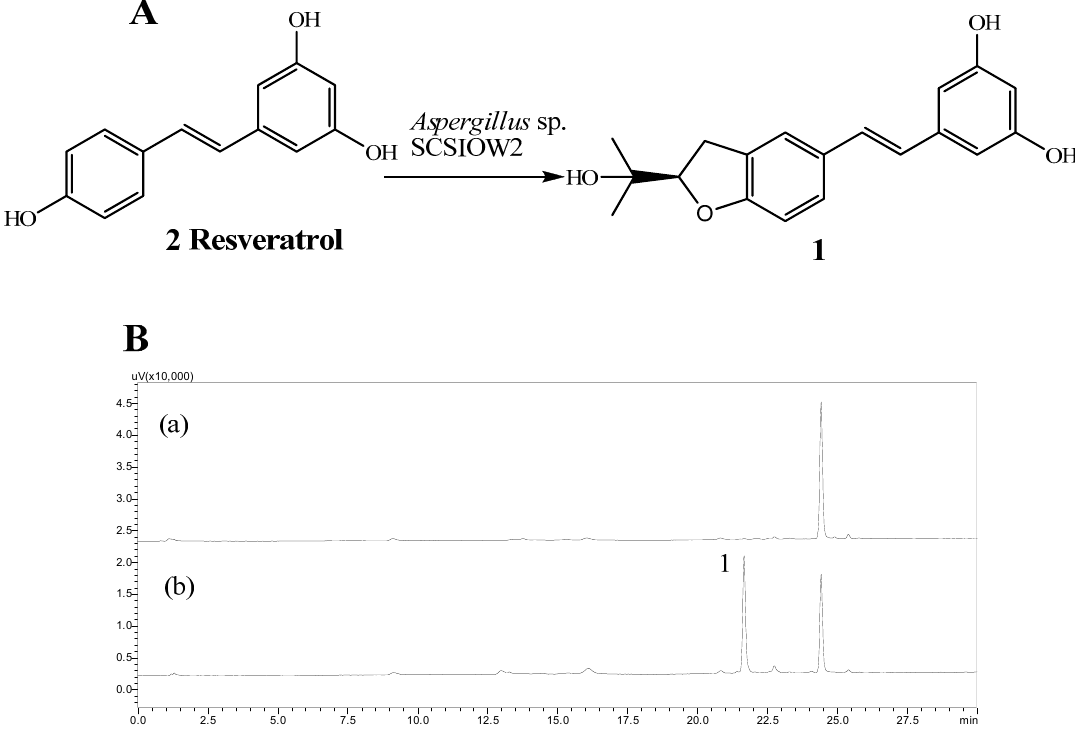
Figure 1. The conversion of trans -resveratrol into 1 is catalyzed by Aspergillus sp. SCSIOW2. ( A ): Structures of trans -resveratrol ( 2 ) and arahypin-16 ( 1 ); ( B ): HPLC-UV chromatogram at 309 nm of EtOAc extracts of untreated ( a ) and resveratrol-treated ( b ) fermentation broth.